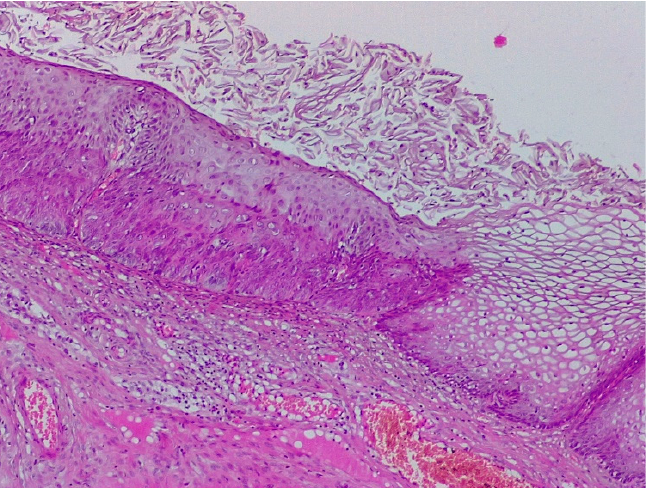
Figure 9. Histological specimen of the previous case illustrating CIN 3 lesion—proliferation of squa- mous cells with abnormal mitosis throughout the entire thickness and acanthosis and parakeratosis of the superficial layers. Right: Koilocyte transformation illustrating the simultaneous presence of two lesions of different severity levels. (Hematoxylin–eosin 10×.)